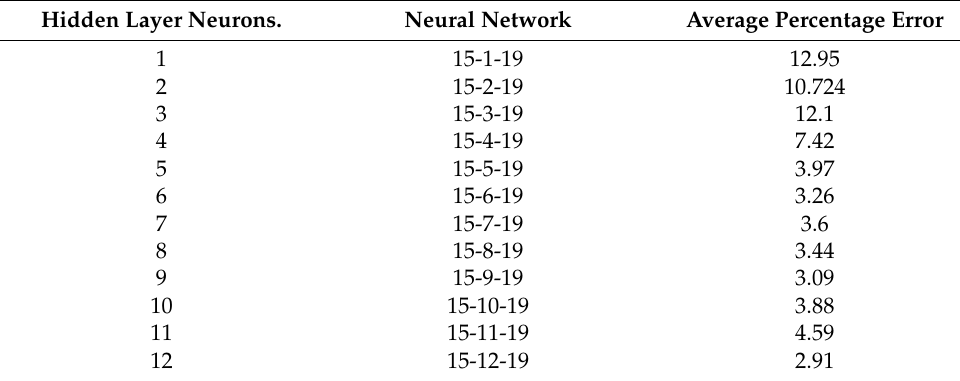
Table A2. Selection of the optimum number of neurons in the hidden layer of MLP based on minimum training